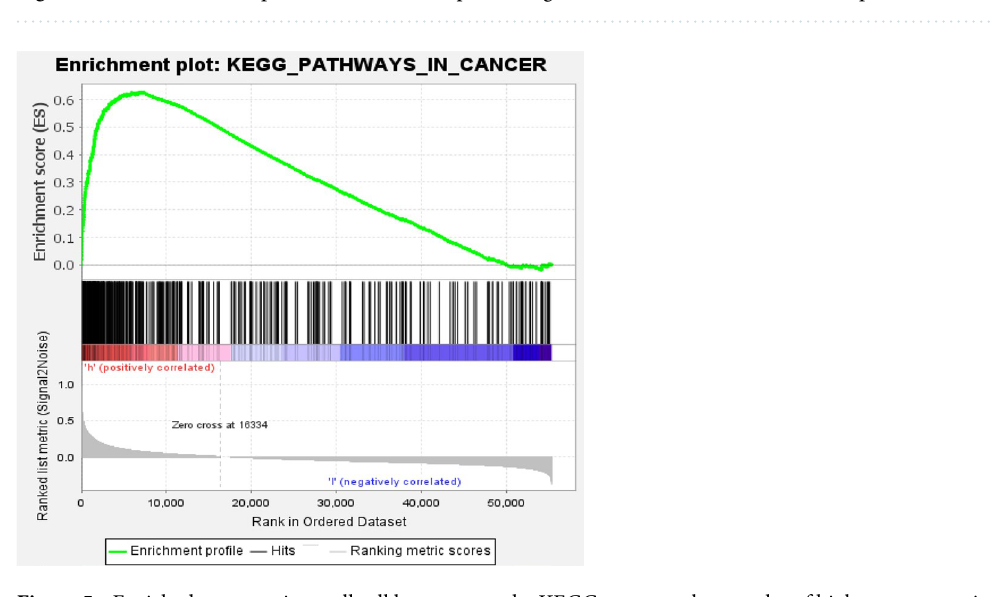
Figure 4. Differentiated expression and Survival period of genes in the normal and tumor sample.